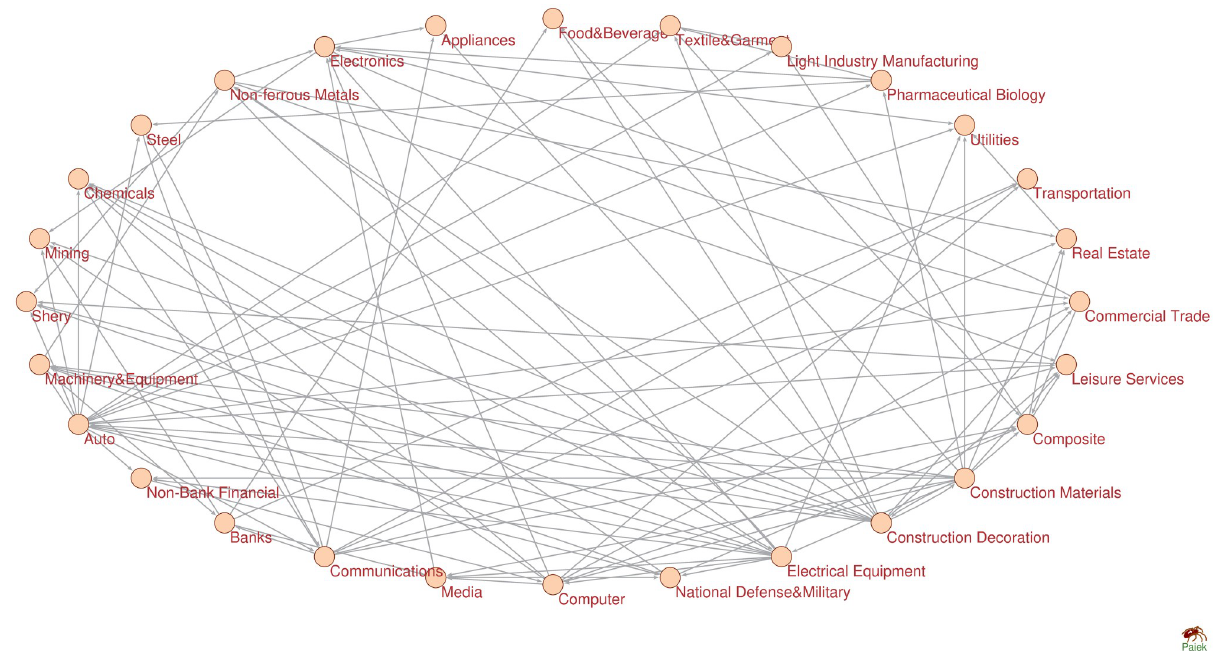
Fig 2. Industry index network. The industry index network is constructed by using PMIME over segment of June 2005–October 2007.